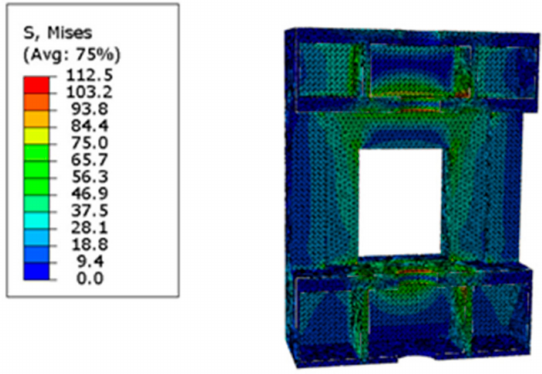
Figure 4. Equivalent stress distribution of the COF